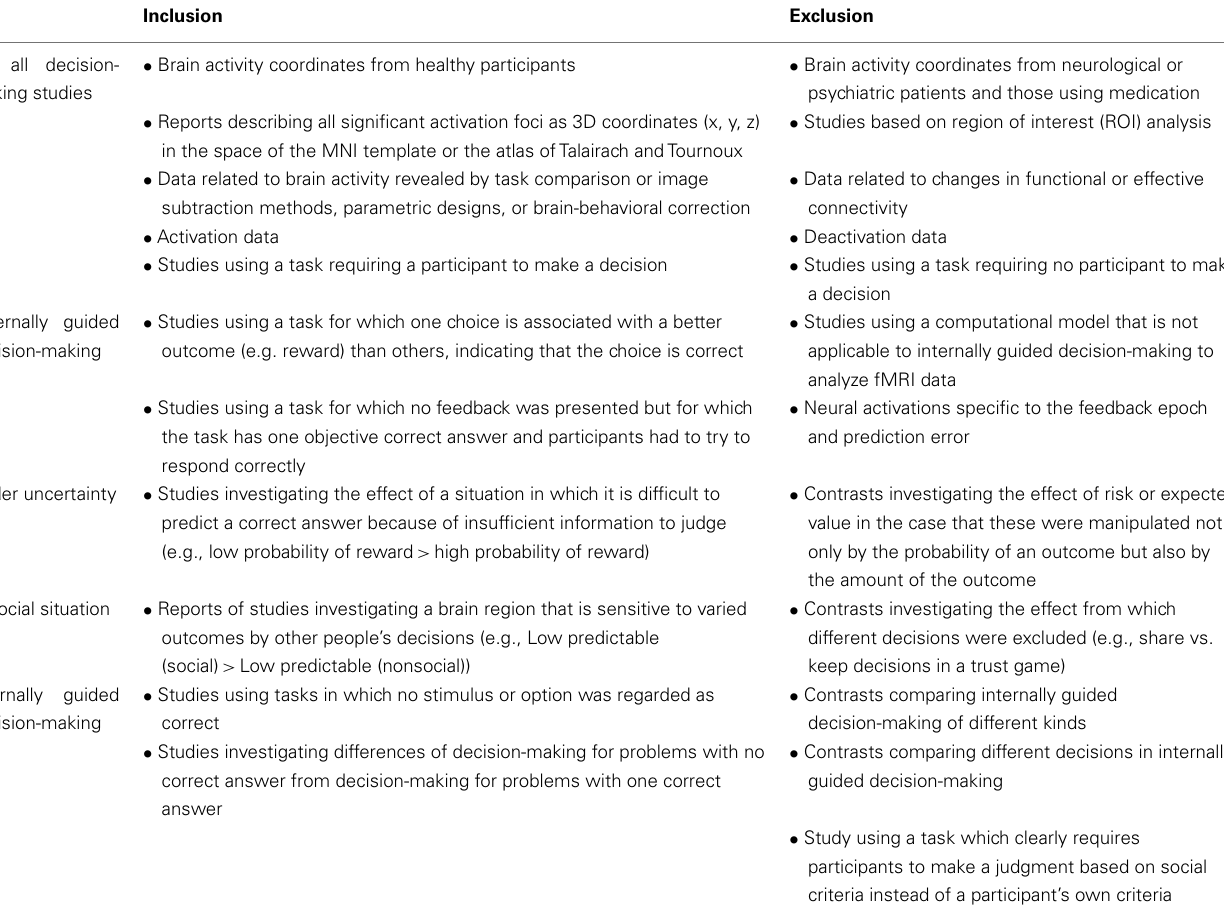
Table 1 | Summary of inclusion and exclusion criteria for meta-analysis